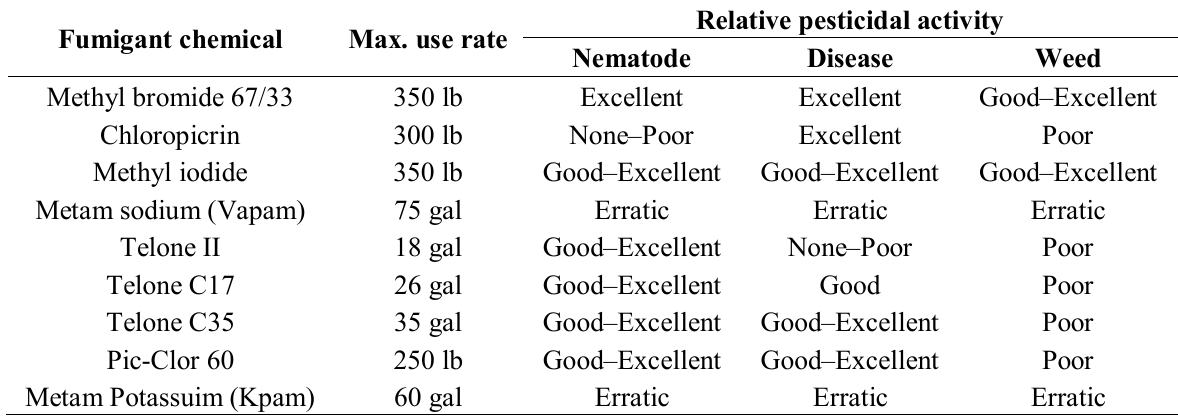
Table 2. Florida maximum use rates and effectiveness of soil fumigant